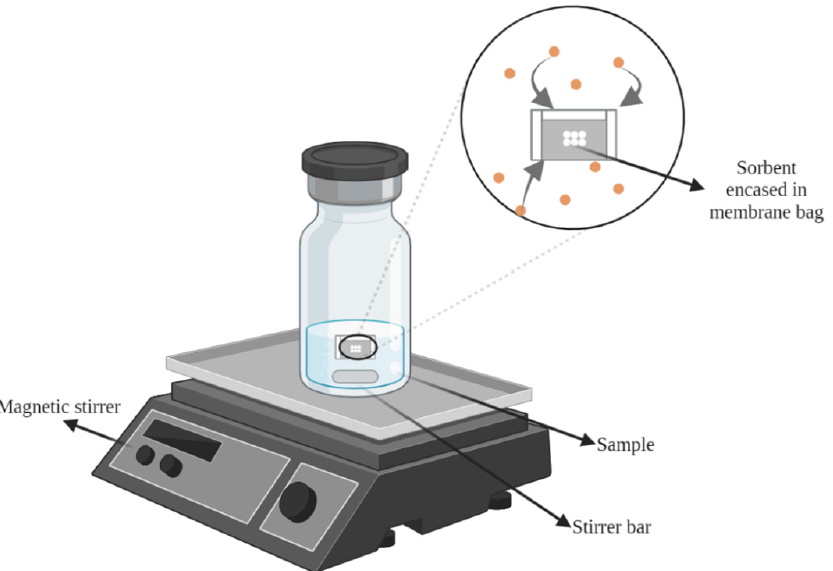
Figure 5. Illustration of µ-SPE system.